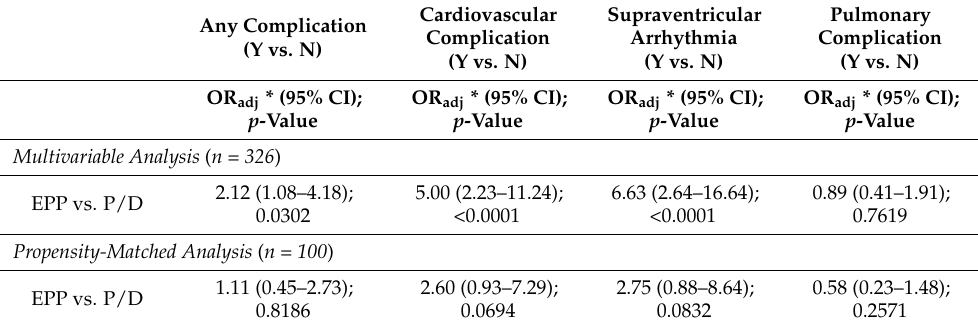
Table 3. Odds of Complications in EPP vs. P/D patients, multivariable and propensity-matched analyses.